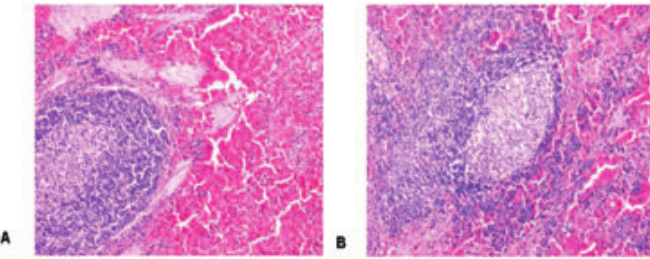
FIGURE 2 - Colloid scintigraphy in sham-operated control animal (L=liver, S=spleen) ( A ) and in autotransplanted animal with 10 spleen chips ( B ) in the 12 th postoperative month, demonstrated by selected images (L=liver, AU= spleen autotransplants). The arrows show to the spot-like enhancement to the spleen autotransplants.